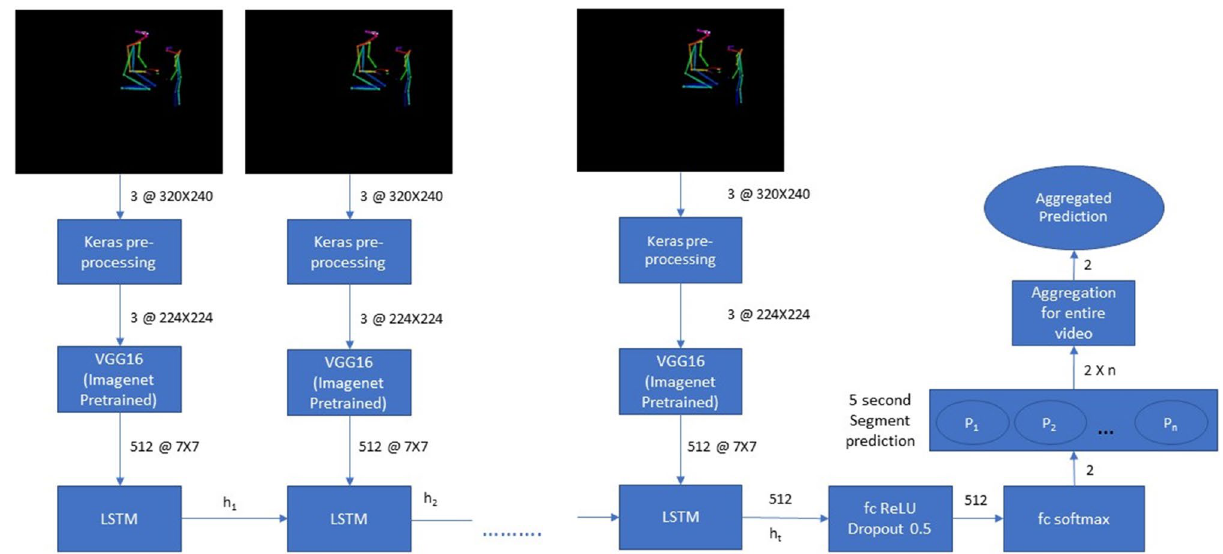
Figure 2. Neural network architecture. The pretrained Convolutional Network VGG16 22 was used to extract the characteristics of all videos split into 5s segments. The output from this feature extraction step was fed into a LSTM network operating with 512 LSTM units. Finally, the output of the LSTM was followed by 512 fully connected ReLU activated layers and a softmax layer yielding two prediction outputs for the given segment. The segment-wise classifications were aggregated for the video’s duration to obtain a final prediction value (ranging from 0 to 1) that we denote “ASD probability”. The video was classified as belonging to a child with ASD if the mean value of ASD probability was superior to 0.5.